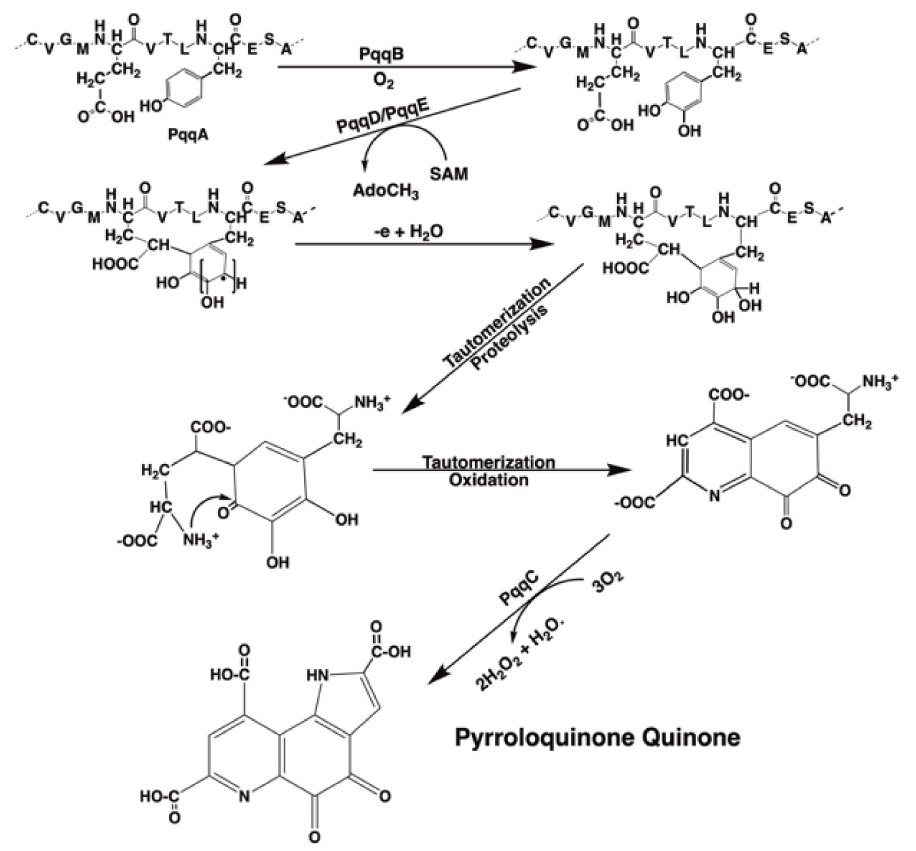
Figure 3. PQQ synthesis. The scheme shown for PQQ synthesis was adapted from the PQQ biosynthetic pathway in Methylobacterium extorquens . Multiple gene products (designated PqqA, PqqB, PqqC, etc.) are required for PQQ synthesis. PQQ synthesis is unusual in that PQQ is derived from the enzymatic annulation of peptidyl tyrosine and glutamic acid found in PqqA. The annulation of the glutamyl and tyrosyl residues is catalyzed by PqqD and PqqE. PqqD is a novel peptide chaperone that forms a ternary complex with the radical S-adenosylmethionine-requiring protein, Pqq E. The annulation step is then followed by oxidation, tautomerization, and the eventual proteolytic